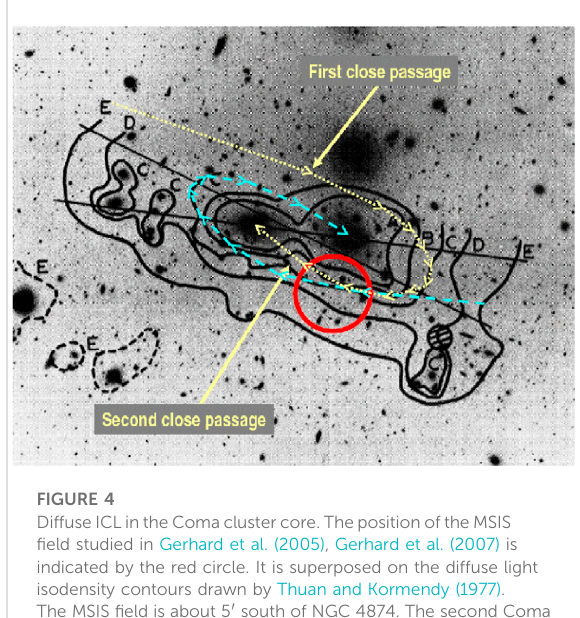
FIGURE 4 DiffuseICLintheComaclustercore.ThepositionoftheMSIS fi eld studied in Gerhard et al. (2005), Gerhard et al. (2007) is indicated by the red circle. It is superposed on the diffuse light isodensity contours drawn by Thuan and Kormendy (1977). The MSIS fi eld is about 5 ′ south of NGC 4874. The second Coma cD galaxy NGC 4889 is7 ′ east (to theleft) of NGC4874. The bright object north of NGC 4874 is a star. Note the strong elongation of the ICL distribution in the Coma cluster core. The likely orbits of NGC 4889 and NGC 4874 up to their present positions are sketched by the yellow dotted and magenta dashed lines, respectively; image reproduced from Gerhard et al. (2007) with